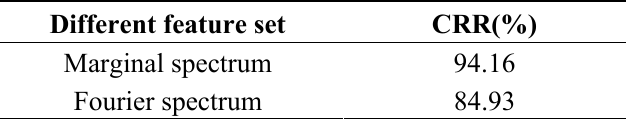
Table 4. The CRR using different feature